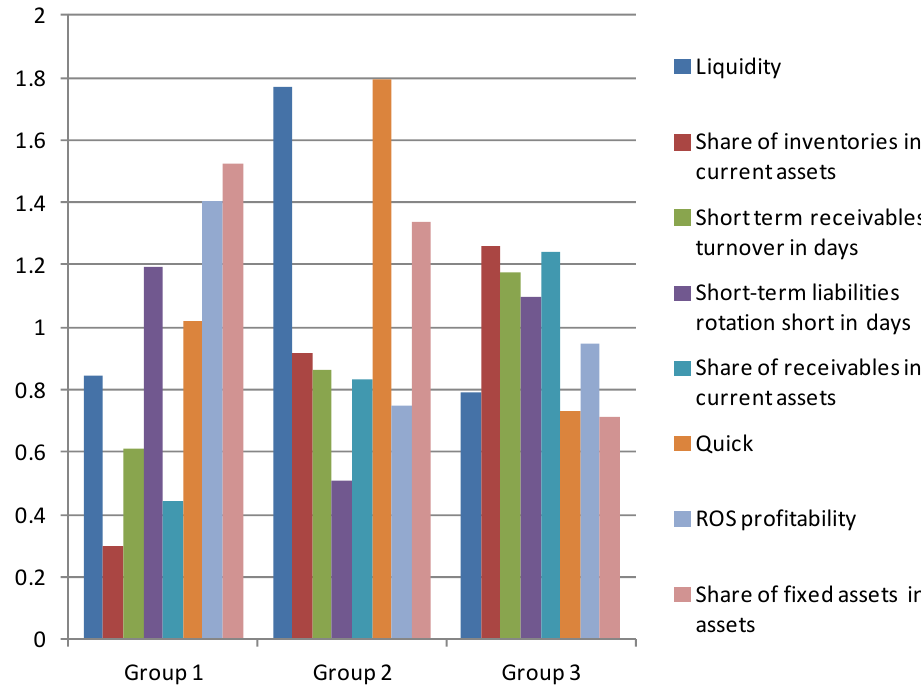
Figure 10. Group means for individual clusters. Source: own study based on the financial statements of the analyzed enterprises.